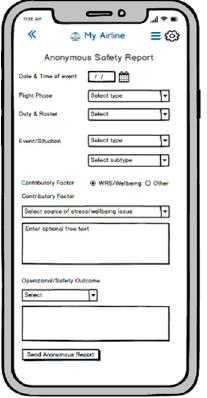
Figure A11. Tool 1: anonymous safety reporting.